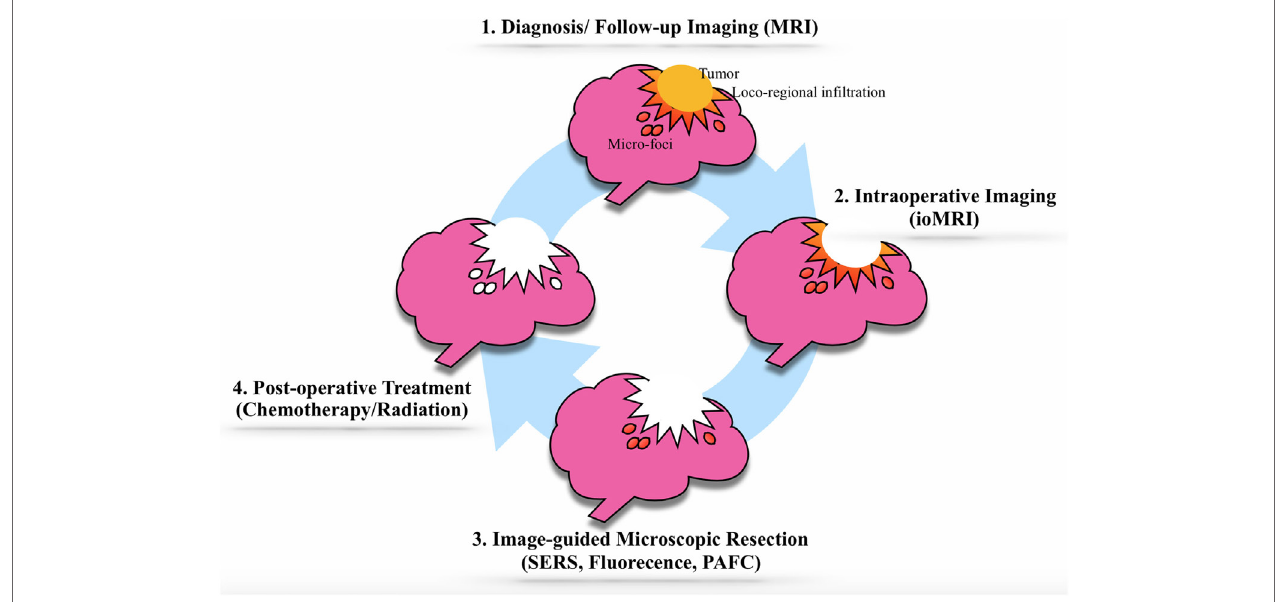
FiGURe 3 | The theranostic cycle. (1) The brain tumor diagnosis is achieved by advanced brain magnetic resonance imaging (MRI) with gadolinium-conjugated gold nanoparticles (GNPs). (2) After the usual surgical debulking of the tumor mass, the loco-regional invasion is identified and removed in two steps: a macroscopic phase [using intraoperative MRI (ioMRI)] and (3) a microscopic phase involving GNPs suitable for Raman imaging, fluorescent imaging, photoacoustic imaging, photoacoustic flow cytometry. (4) The GNPs can be loaded with therapeutic agents, such as chemotherapy agents, that can target and destroy potential tumor residuals. If the tumor should recur, the cycle may be